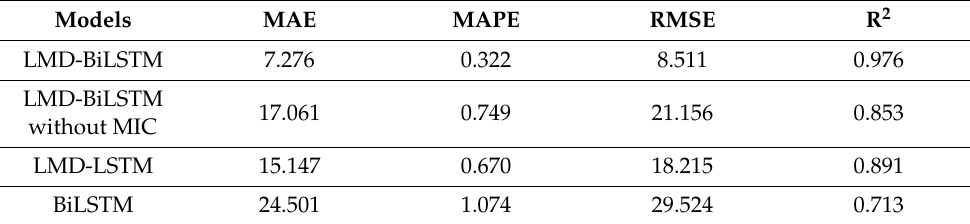
Table 2. Comparison of four models for landslide displacement prediction.